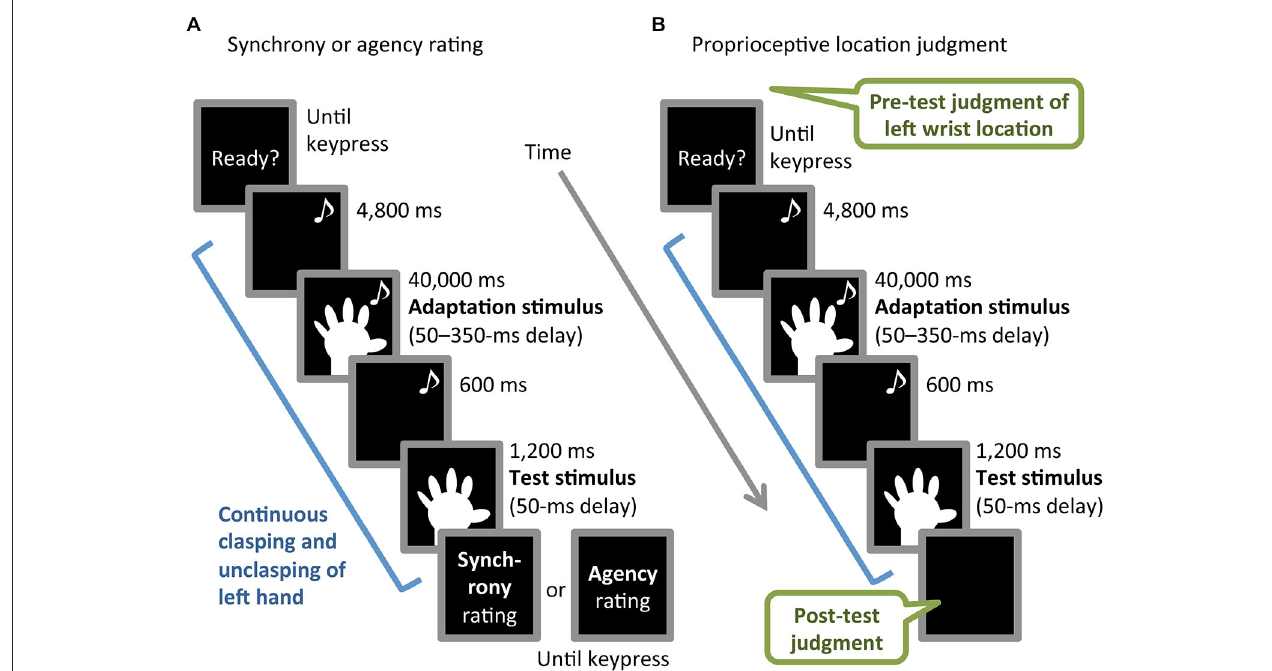
FIGURE 2 | Schematic illustration of (A) synchrony or agency rating task and (B) proprioceptive location-judgment task . Musical notes indicate periods with an auditory